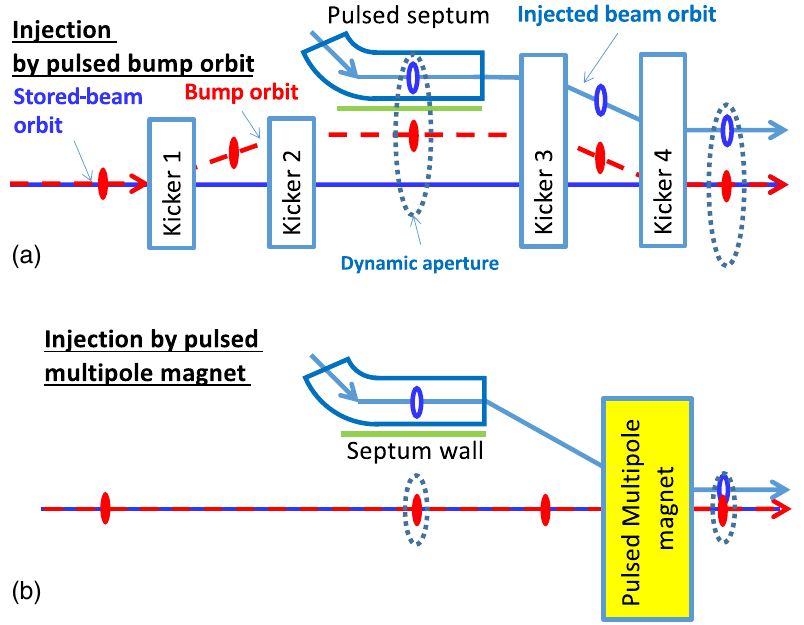
FIG. 1. Comparison of injection schemes using a conventional pulsed bump orbit (A) and a pulsed multipole magnet (B). The dynamic aperture is indicated schematically to illustrate the merging of the injection beam into the narrow dynamic aperture.